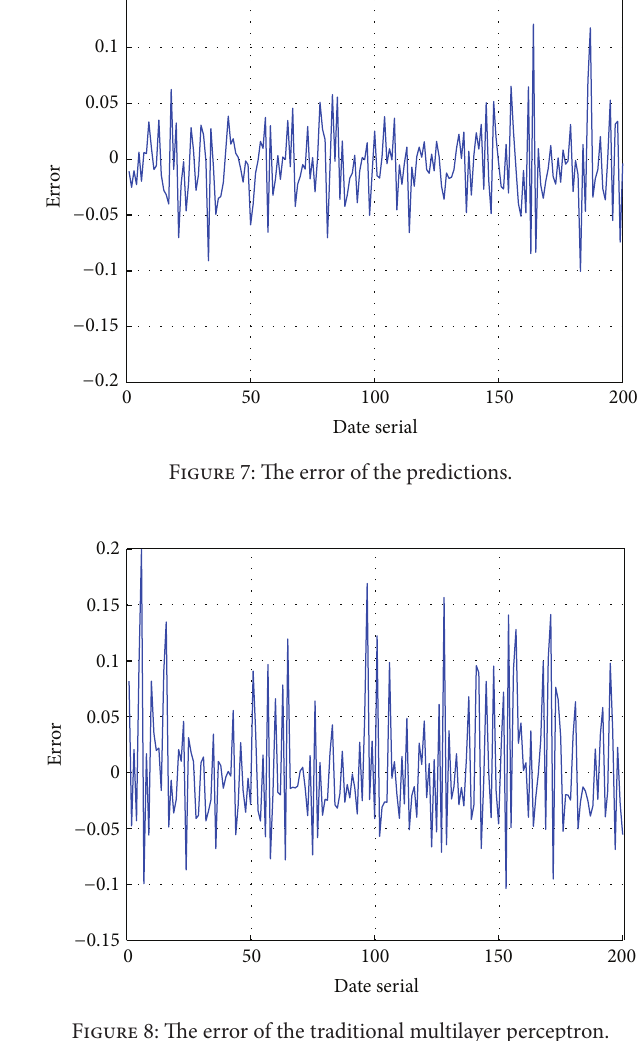
Figure 8: The error of the traditional multilayer